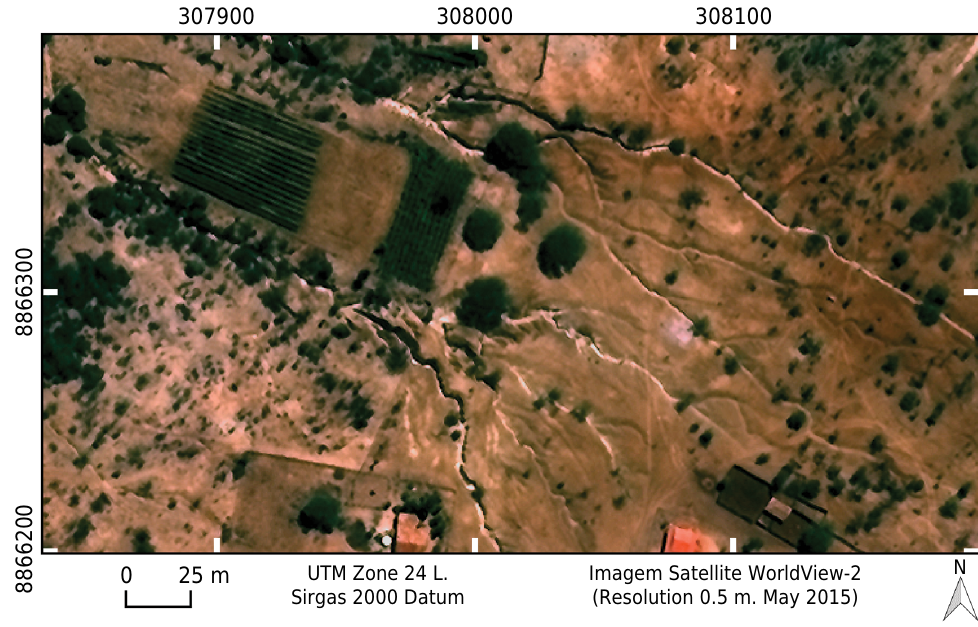
Figure 5. Visualization of gullies and larger rills in the surroundings of the community of Taboa – Campo Formoso-BA, Brazil, on a WorldView-2 image. Central point of the image is located at the UTM Coordinate 308066E 8866300N Zone